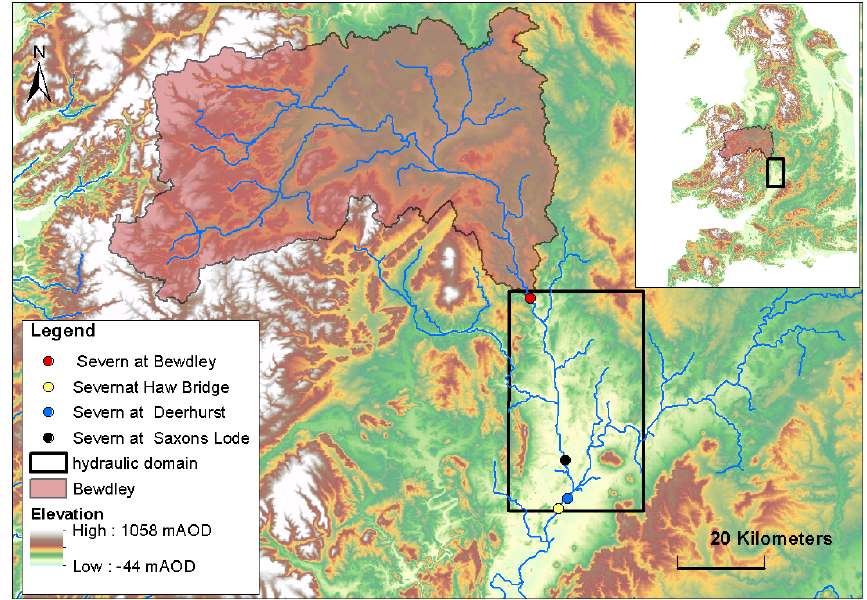
Figure 2. Study area: river Severn (UK). Only the boundary condition in Bewdley is taken into account. Within the sub-catchment upstream of Bewdley a lumped hydrologic model is used to determine the input for the hydraulic model along the river Severn downstream. The dots represent the existing gauging stations where the performance of the DA framework is evaluated. The black square is the hydraulic domain where LISFLOOD-FP